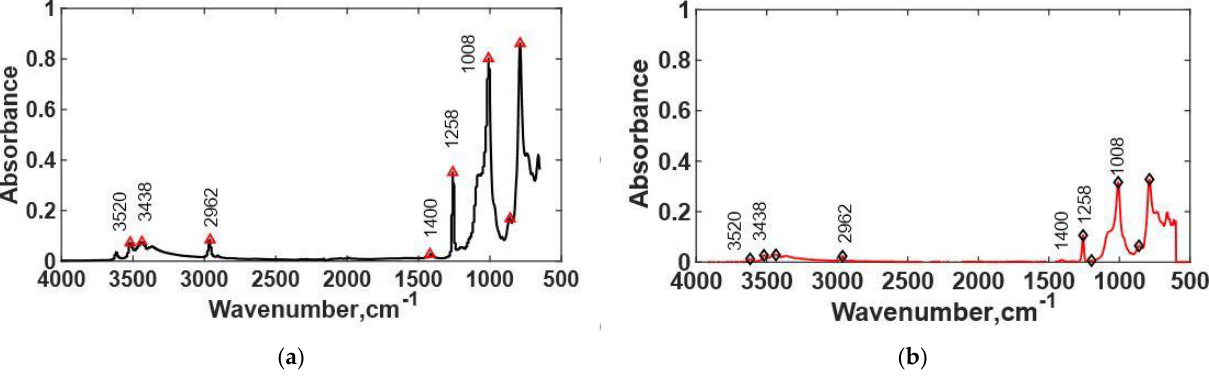
Figure 16. ( a ) FTIR spectra of TIM A preaged, and ( b ) FTIR spectra of TIM A thermal-aged at 125 °C.